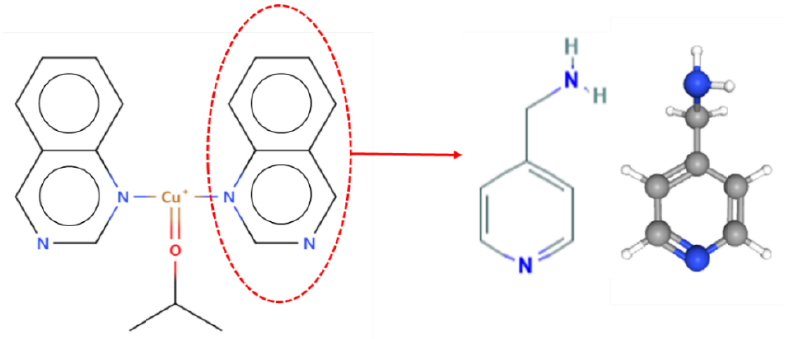
Figure 4. 4- AMP’s selection process (CCDC Refcode: HECYUJ). Figure 4. 4-AMP’s selection process (CCDC Refcode: HECYUJ).